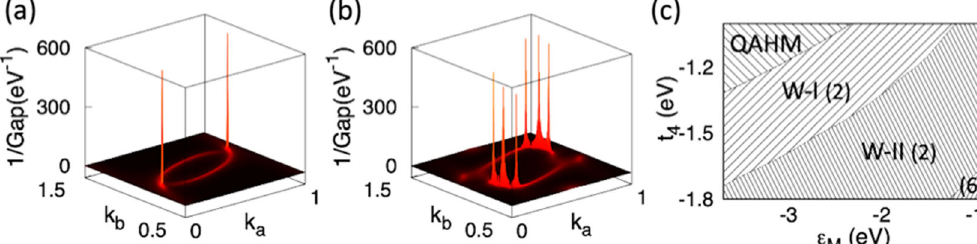
Fig. 5 Weyl points and phase diagram. a A pair of Weyl points in the k b = k c mirror plane with parameters t 1 = − 1, t 2 = − 0.4, t 3 = 1.3, t so = = − 0.1, t = − 1.3, t = − 0.85, and ε = − 2.4. b Three pairs of Weyl points in the mirror plane with parameter t − 0.1, t Rashba 4 5 M 1.3, t so = − 0.1, t Rashba = − 0.1, t 4 = − 1.8, t 5 = − 1.0, and ε M = − 1.0 (all units in eV). c The phase diagram in the t 4 and ε M parameter space with t 1 = − 1, t 2 = − 0.4, t 3 = 1.3, t so = − 0.1, t Rashba = − 0.1, t 5 = − 1.0, and ε S = − 4.0, where QAHM, W-I, and W-II stand for compounds with quantum anomalous Hall metal and type-I and type-II Weyl semimetals, respectively; and the numbers in parentheses indicate the number of Weyl points in the k b = k c mirror plane. Here all the units of the parameters are in